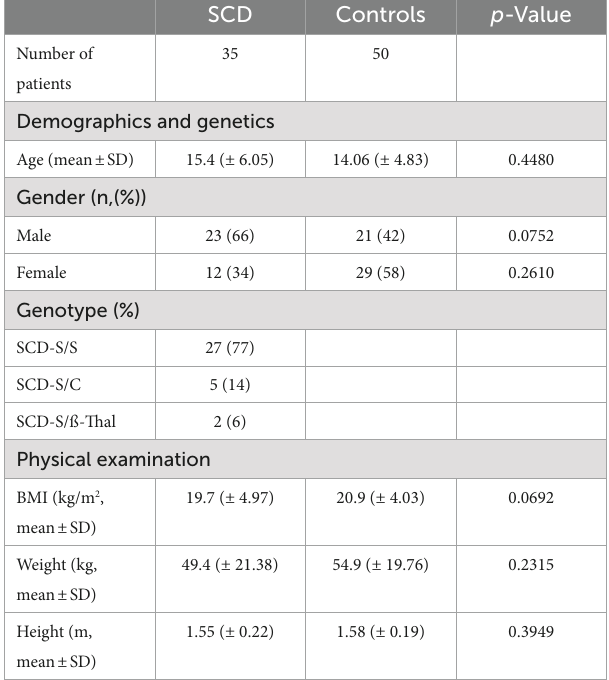
TABLE 1 Clinical characteristics of SCD patients and controls. SCD Controls p